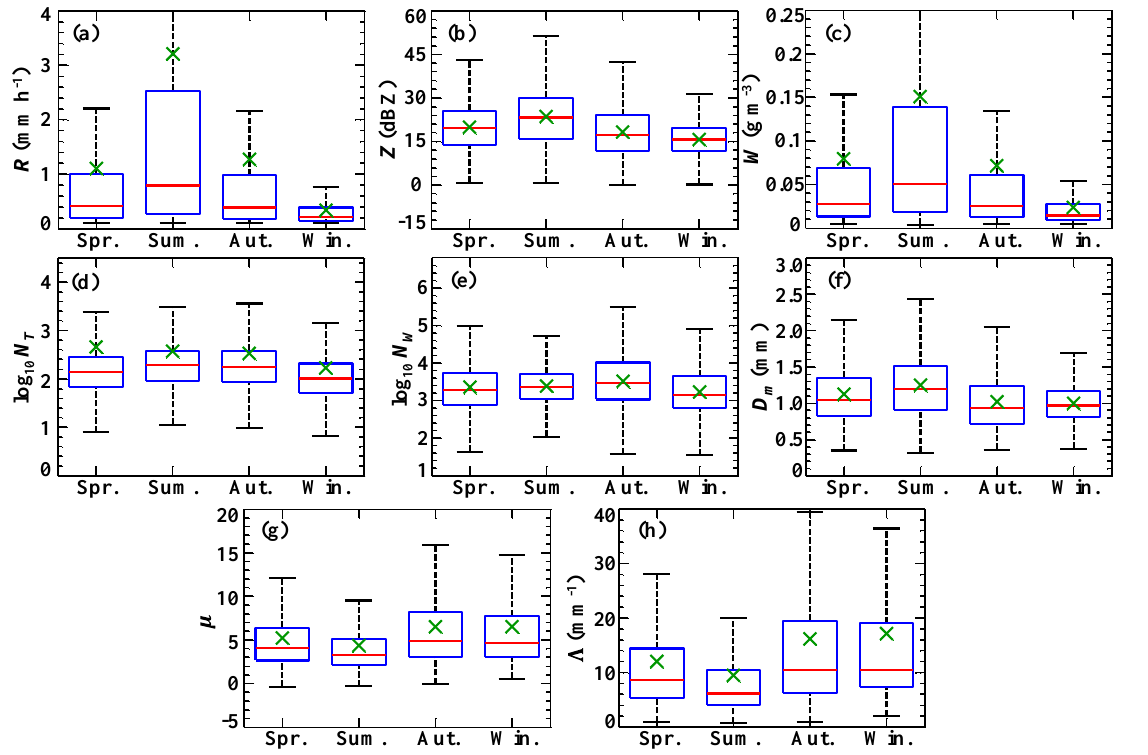
Figure 3. Seasonal boxplots of RSD-integrated quantities and fitted Gamma parameters. (a) ‒ (h) are rain rate R (mm h − 1 ), radar reflectivity Z (mm 6 m − 3 ), water content W (g m − 3 ), total number concentration N T (m − 3 ), generalized intercept parameter N w (m − 3 mm − 1 ), mass-weighted mean diameter D m (mm), shape parameter µ , and slope parameter Λ (mm − 1 ). For each box, the central red crossbar represents the median; the bottom and top edges of the box indicate the 25th and 75th percentiles, respectively; the bottom and top of the dashed vertical lines indicate the 5th and 95th percentiles, respectively; the green cross denotes the average. The units of N T and N W are m − 3 and m − 3 mm − 1 , respectively.